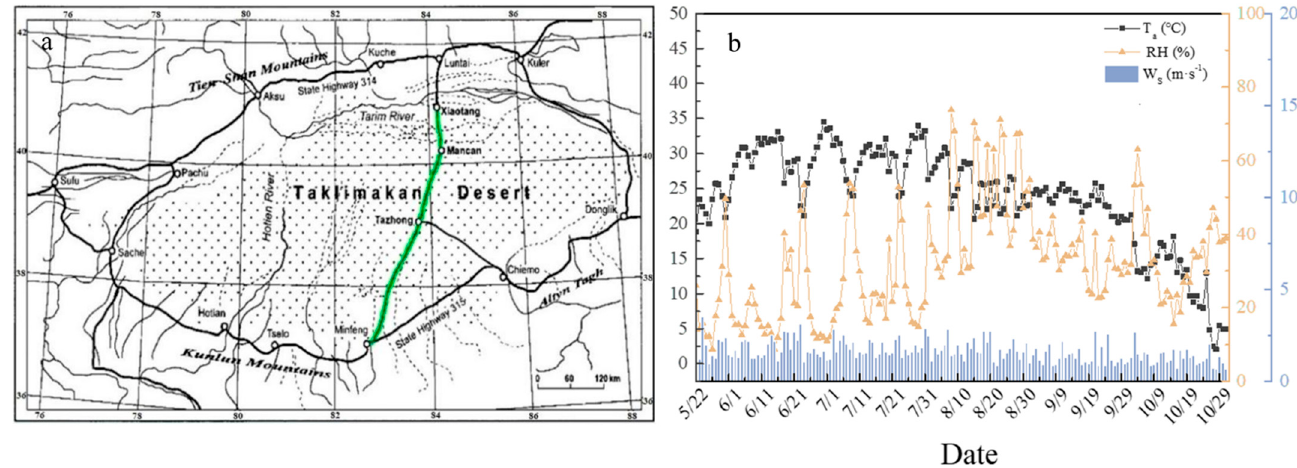
Figure 1. Taklimakan Desert Highway ( a ), and atmospheric temperature (T a ), air humidity (RH), and wind speed (W S ) at the height of 2 m in the middle of the Taklimakan Desert in 2016 ( b ).